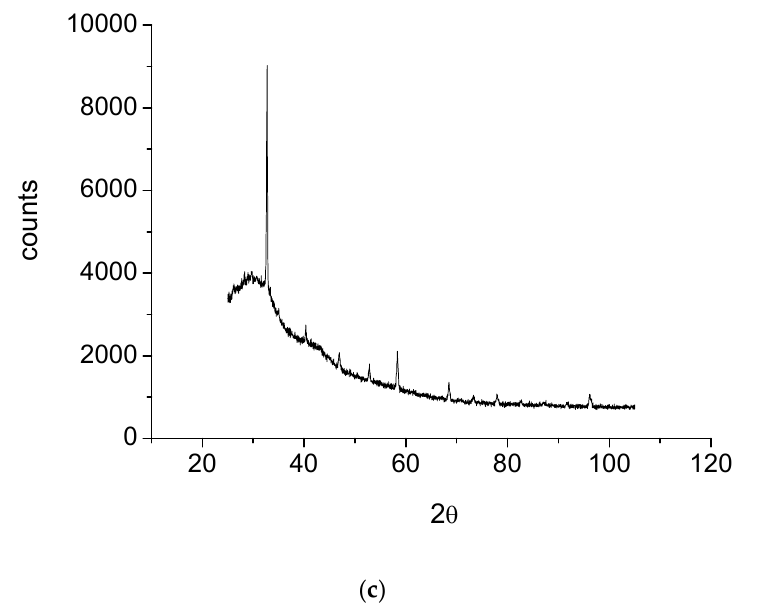
Figure 7. ( a ) XRD diagram of Complex 1 ; ( b ) XRD diagram of Complex 2 ; ( c ) XRD diagram of Complex 3 . Table 4. XRD spectral data for the synthesized complexes.